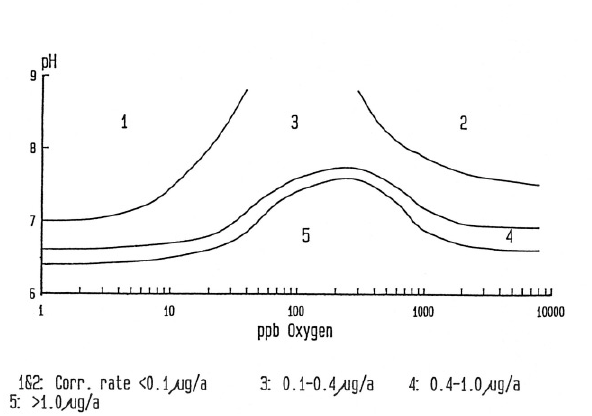
Figure 6: Corrosion date at various operating